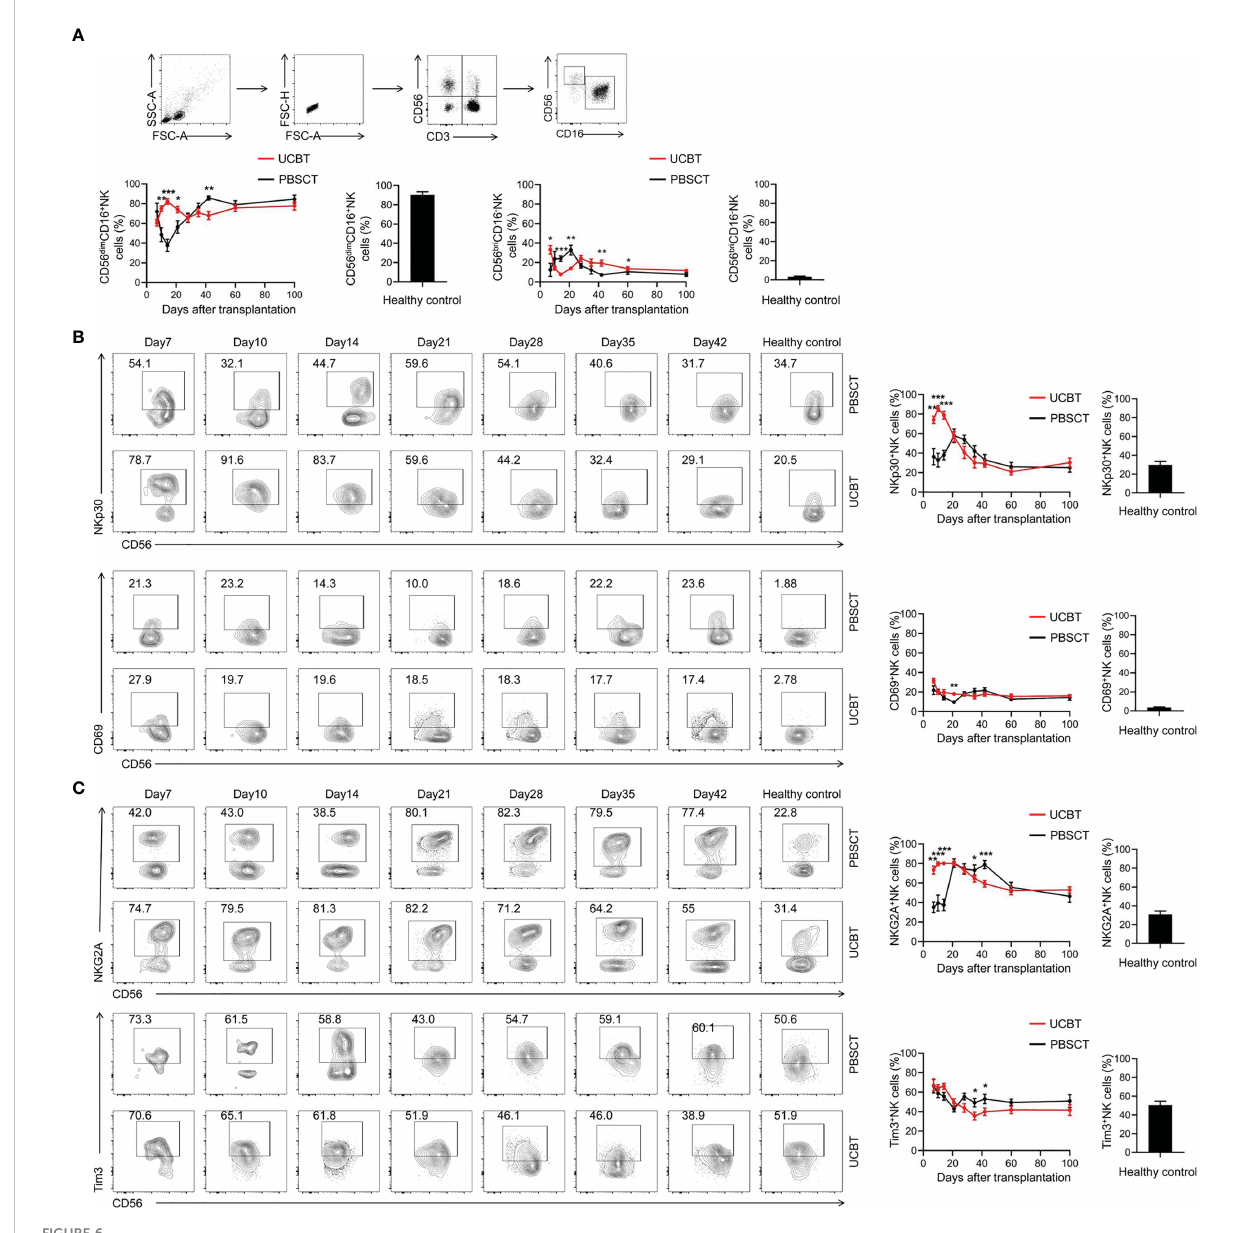
FIGURE 6 The dynamic changes in the NK cell subpopulations and the expression levels of immune-activating molecules on the NK cells. (A) The frequencies of NK cell subpopulations during the early posttransplant period after UCBT and PBSCT. Representative fl ow cytometry contour plots and the dynamic changes in the expression levels of (B) NKp30, CD69, (C) NKG2A and Tim3 in the gated NK cells during the early posttransplant period after UCBT and PBSCT. The histogram shows data for the healthy control group. The data was analyzed by the Mann – Whitney U test and represented as means ± SEM. * p <0.05; ** p <0.01; *** p